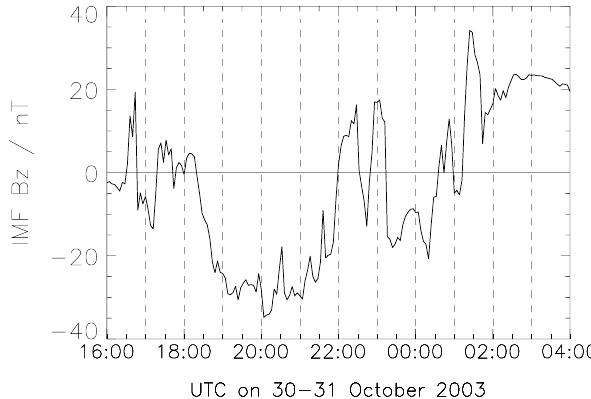
Fig. 2. Four minute averaged IMF B z at the ACE satellite (GSE coordinates).